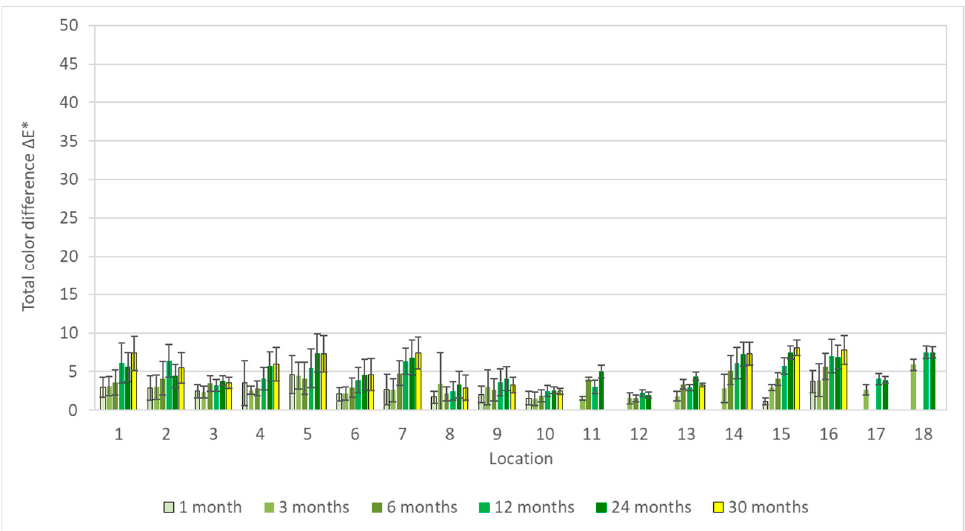
Figure 7. Total color difference of zinc corrosion coupons after 1, 3, and 30 months of exposure.